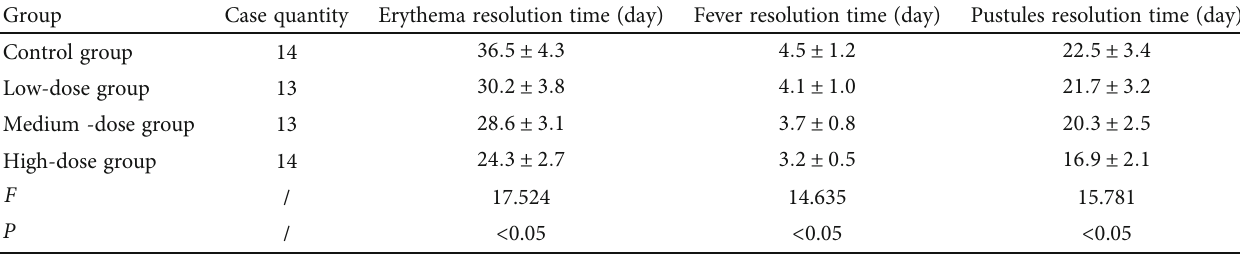
Table 1: Comparison of the time to symptom resolution in the four groups.